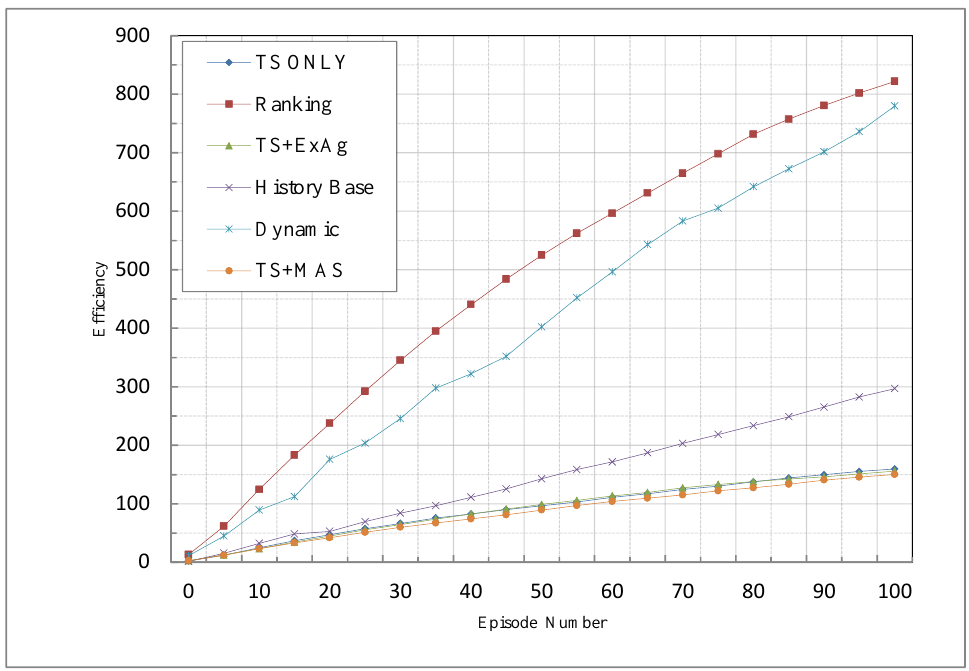
Figure 7. Comparison of MCA methods based on efficiency